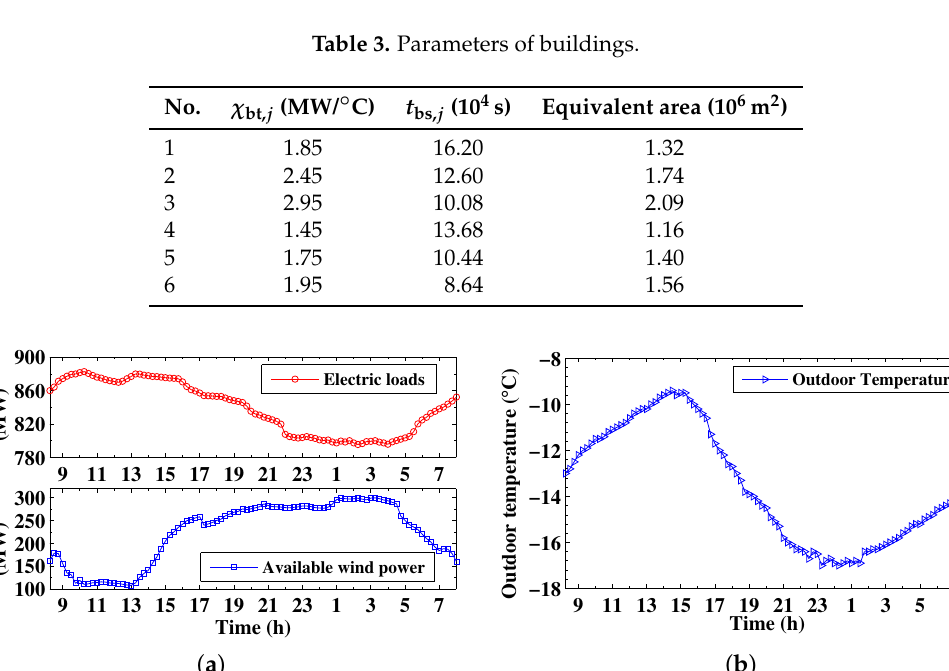
Figure 5. Profiles of the typical day during the heating season: ( a ) total electric loads and forecast wind power; ( b ) outdoor